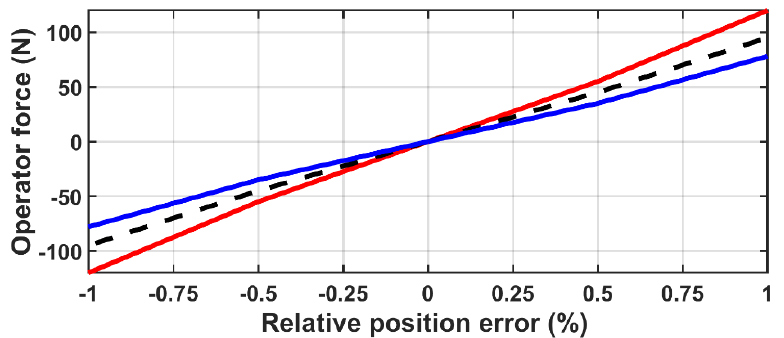
Figure 9. Diagram of correlation between the operator force and relative position error: red line for p = 0.6 MPa, dashed line for p = 0.4 MPa, blue line for p = 0.2 MPa.